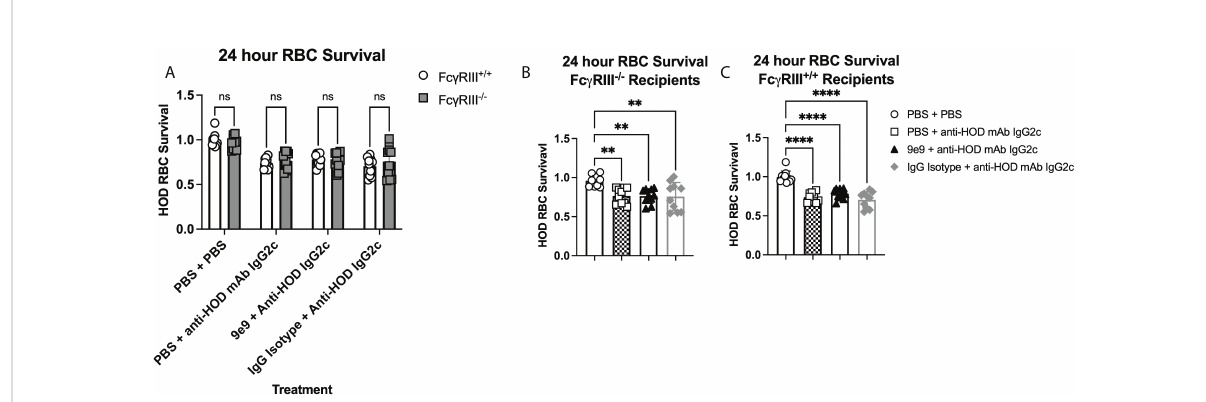
FIGURE 4 Fc g RI is suf fi cient to mediate RBC clearance with IgG2c. Recipient mice were passively immunized with 1 m g of anti-HOD IgG2c followed by an RBC transfusion 2 hours later. Some animals received an infusion of 1 m g of 9e9 or IgG isotype control 30 minutes prior to passive